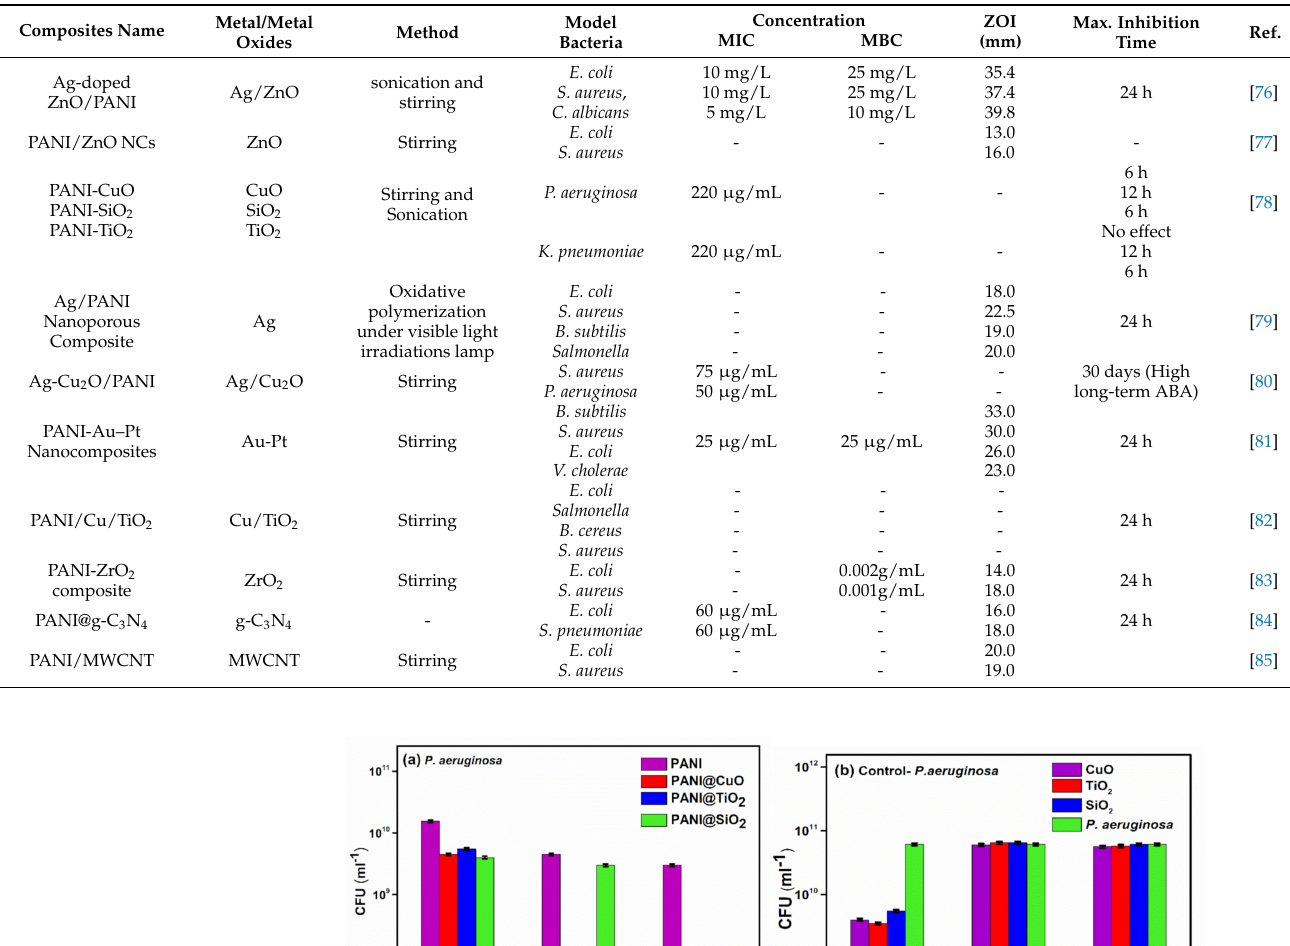
Table 2. Summary of PANI based composites and their antibacterial properties.